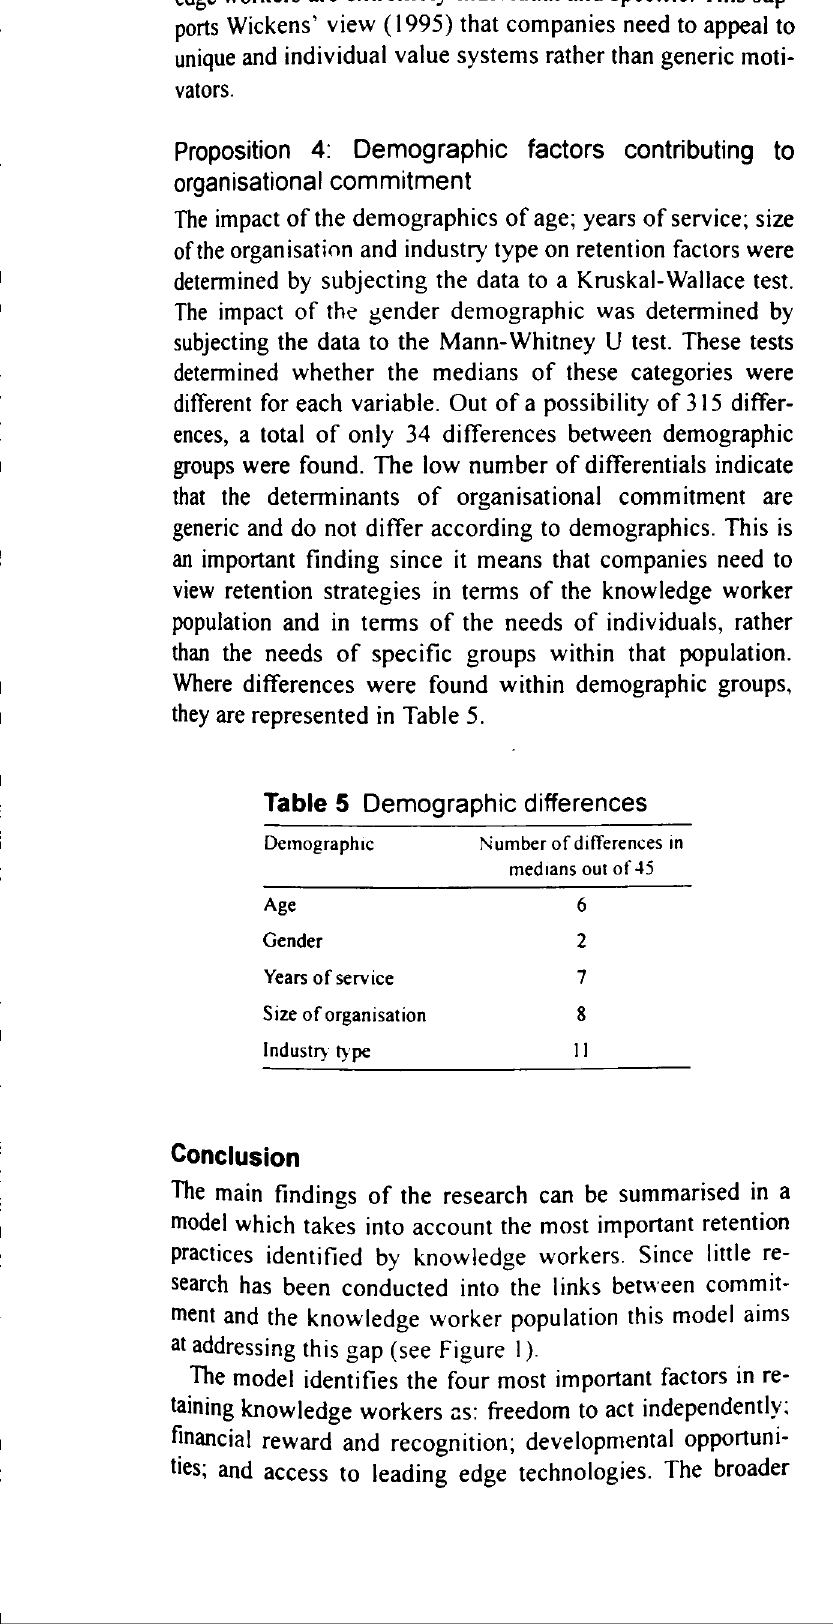
Figure I Model of retention strategies to promote knowledge worker